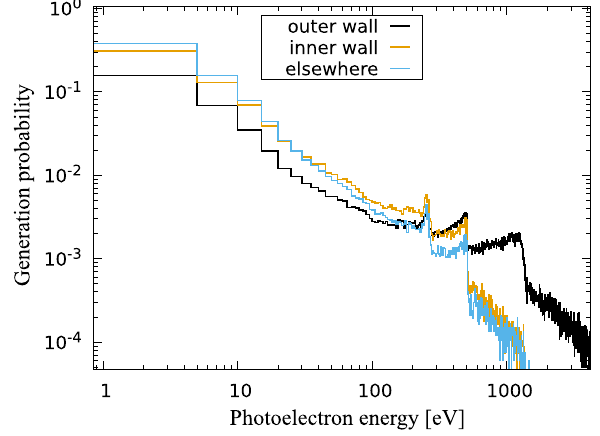
FIG. 20. The energies of photoelectrons emitted from the inner wall and elsewhere are lower than those emitted from the outside wall. The plotted distributions are summed over the dipole regions. Since lower energy photons are more likely to be reflected, and the inner wall and elsewhere (including top and bottom) are struck exclusively by reflected photons, the energy of the photoelectrons is likewise lower. These distributions are used as input to the electron cloud buildup simulations. (Beam energy is 5.3 GeV.)